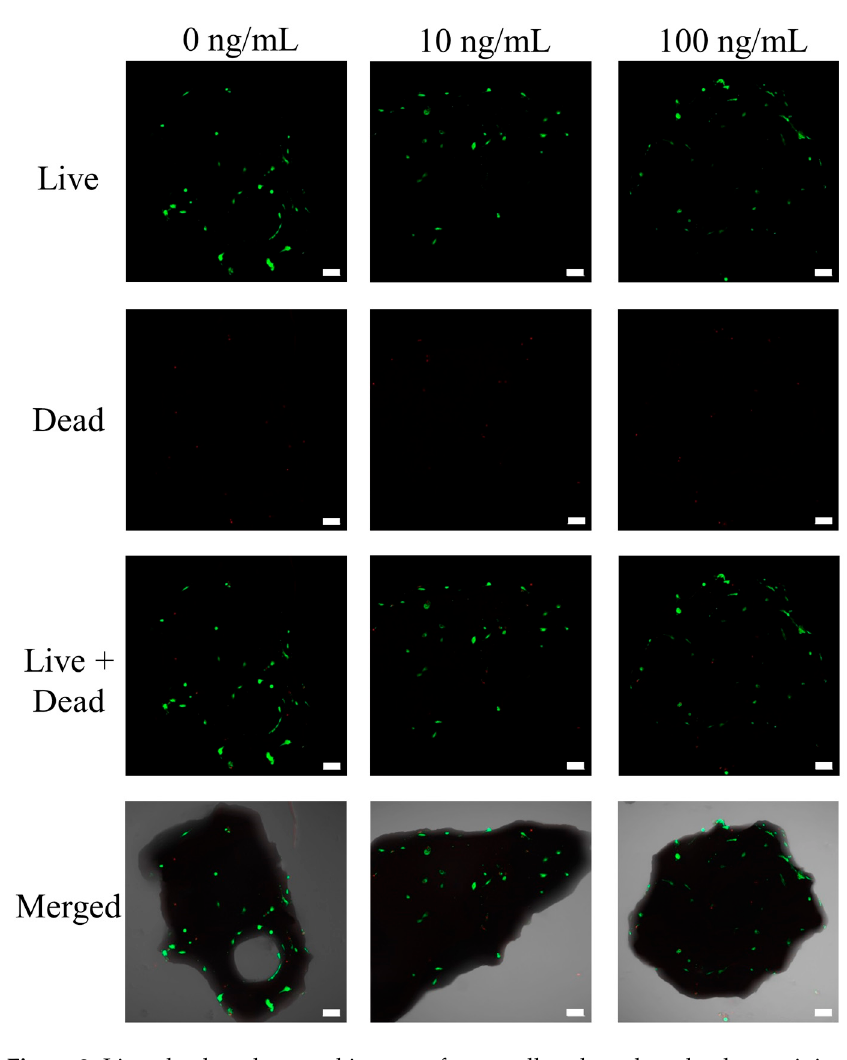
Figure 2. Live, dead, and merged images of stem cells cultured on the deproteinized bovine bone mineral. Scale bar indicates 100 µ m (original magnification: × 50).